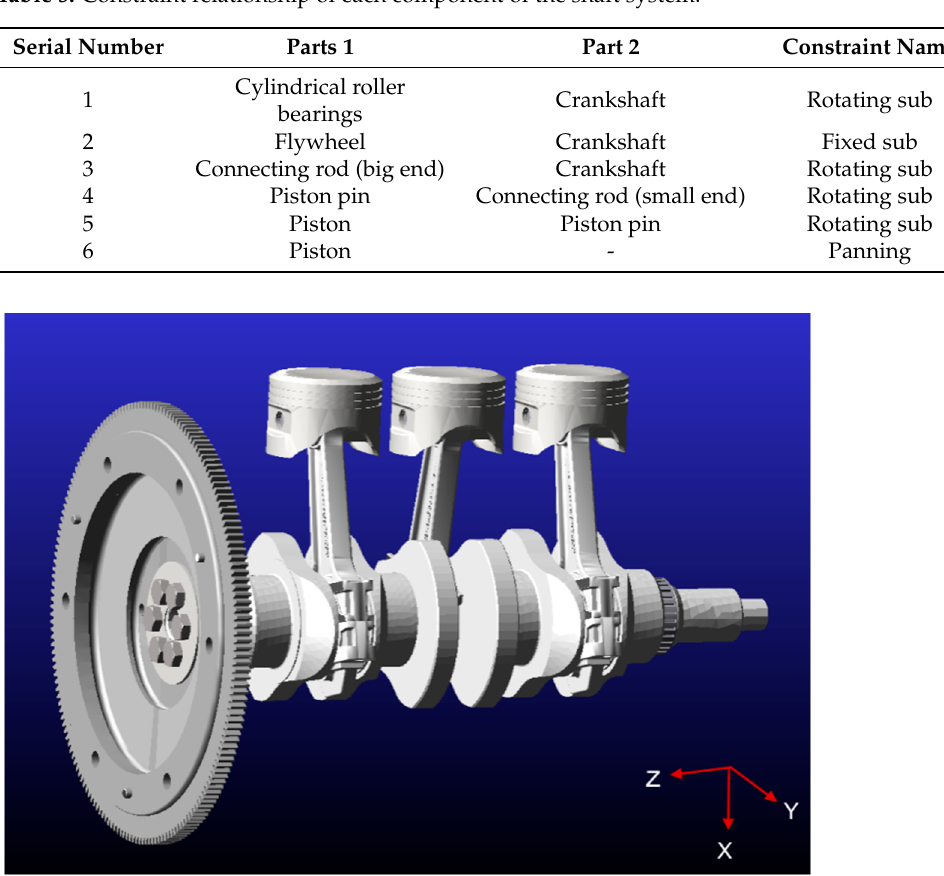
Figure 10. Adams simulation